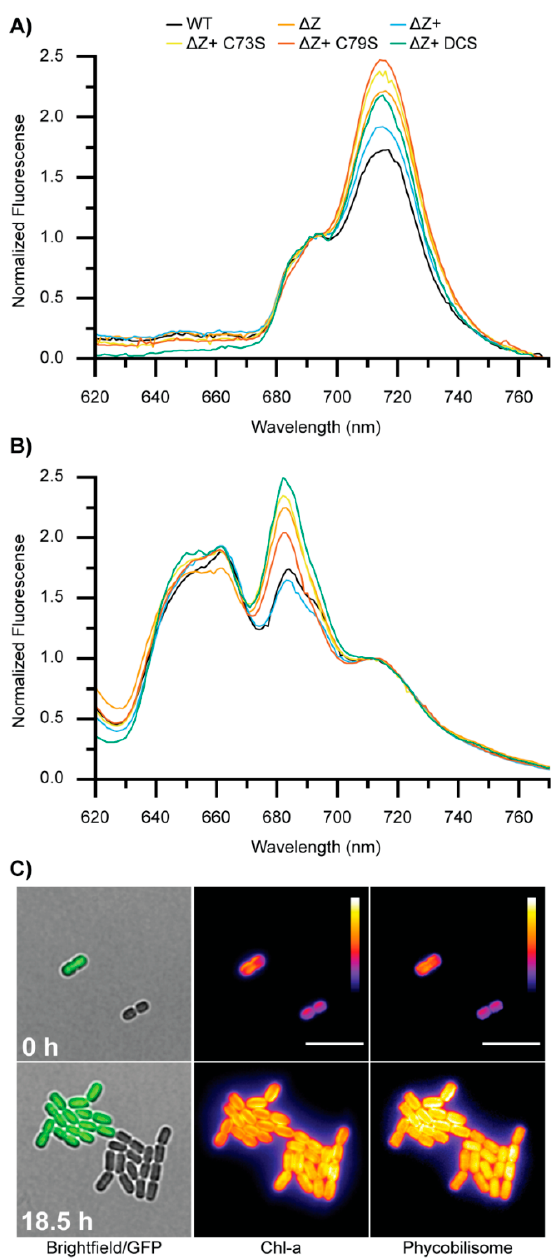
Figure 6. Bulk 77 K emission spectra and single-cell analysis of growth and fluorescence at room temperature. ( A ) 77 K fluorescence emission spectra for each cell line produced by chlorophyll excitation at 440 nm normalized to PSII max emission (692 nm). Increased PSI:PSII ratio is observed for Δ Z and mutant complement lines relative to Δ Z and Δ Z+. ( B ) 77 K fluorescence emission spectra produced by phycobilisome excitation at 580 nm normalized to PSI max emission (712 nm). Increased energy transfer to PSII is observed in Δ Z and cysteine mutants. ( C ) Snapshots from time-lapse imaging (Supplementary Movies S1–S3) showing growth and fluorescent properties of ∆ Z and control WT-GFP cells under identical conditions for 18.5 h. Specific excitation/emission filters were used to monitor fluorescence of GFP (green), Chl-a (Intensity scale = 177–3000 A.U.; purple-white), and phycobilisomes (Intensity scale = 177–1096 A.U.; purple-white). Scale bar = 10 μ m.